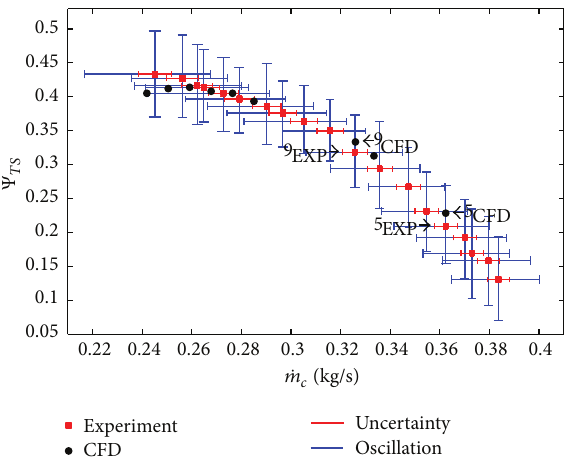
Figure 8: Measured versus computational stagnation-to-static pres- sure rise characteristic for both stages combined.